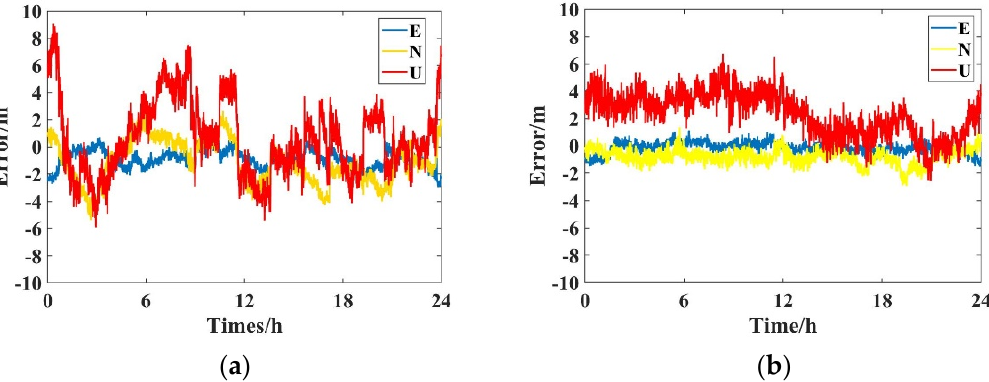
Figure 1. CUT0 one-day BDS/GPS SPP positioning results.(where ( a ) represents the BDS/GPS SPP positioning error when the observation value is not corrected by TGD, and ( b ) represents the BDS/GPS SPP positioning error after the observation value is corrected by TGD).